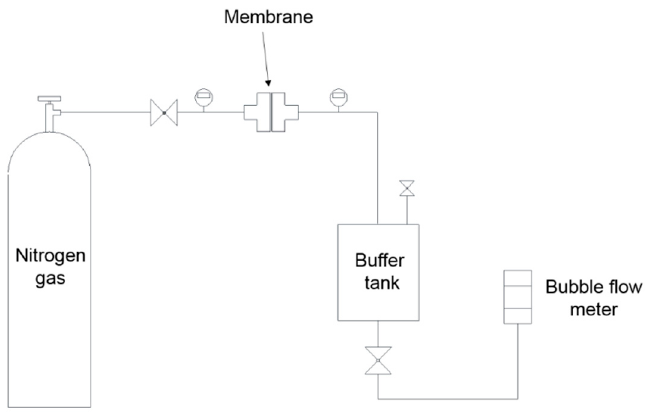
Figure 3. Schematic diagram of gas permeability measurement system.